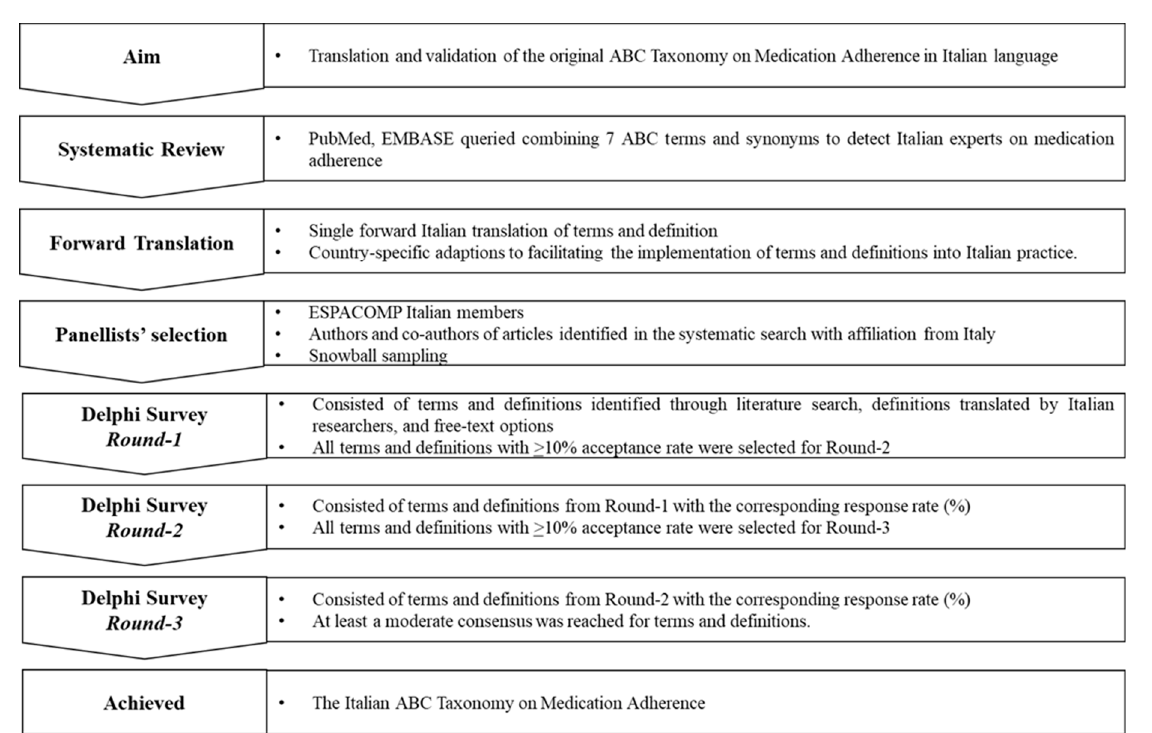
Figure 1. Key steps of the study